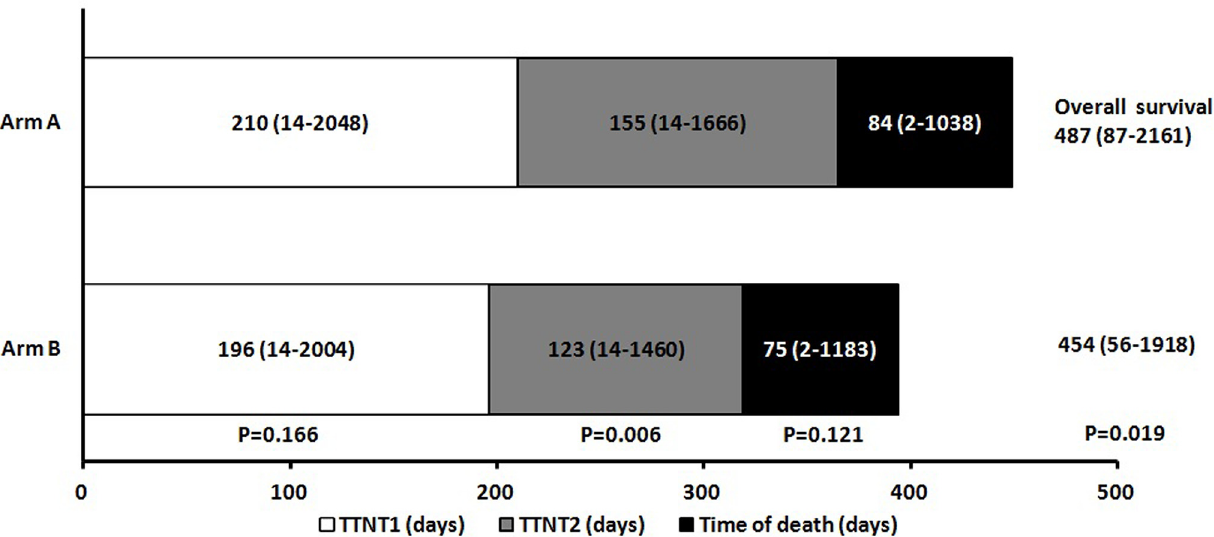
Fig 2. Comparison of survival in metastatic colorectal cancer patients treated with irinotecan followed by oxaliplatin-based regimens or the reverse sequence. The median first time to next treatment (TTNT1) in arm A (irinotecan followed by oxaliplatin-based regimens) was 210 days (14 − 2048). It was 196 days (14 − 2004) in arm B (oxaliplatin followed by irinotecan-based regimens). TTNT1 was not significantly different between patients in arm A and arm B (p = 0.17). Moreover, the median second time to next treatment (TTNT2) in arm A and arm B was 155 days (14 − 1666) and 123 days (14 − 1460), respectively. TTNT2 was longer for patients in arm A than for those in arm B (p = 0.006). In terms of overall survival (OS), the median OS time for arm A and arm B was 487 days (87 − 2161) and 454 days (56 − 1918), respectively. OS was significantly longer for patients in arm A than for those in arm B (p =